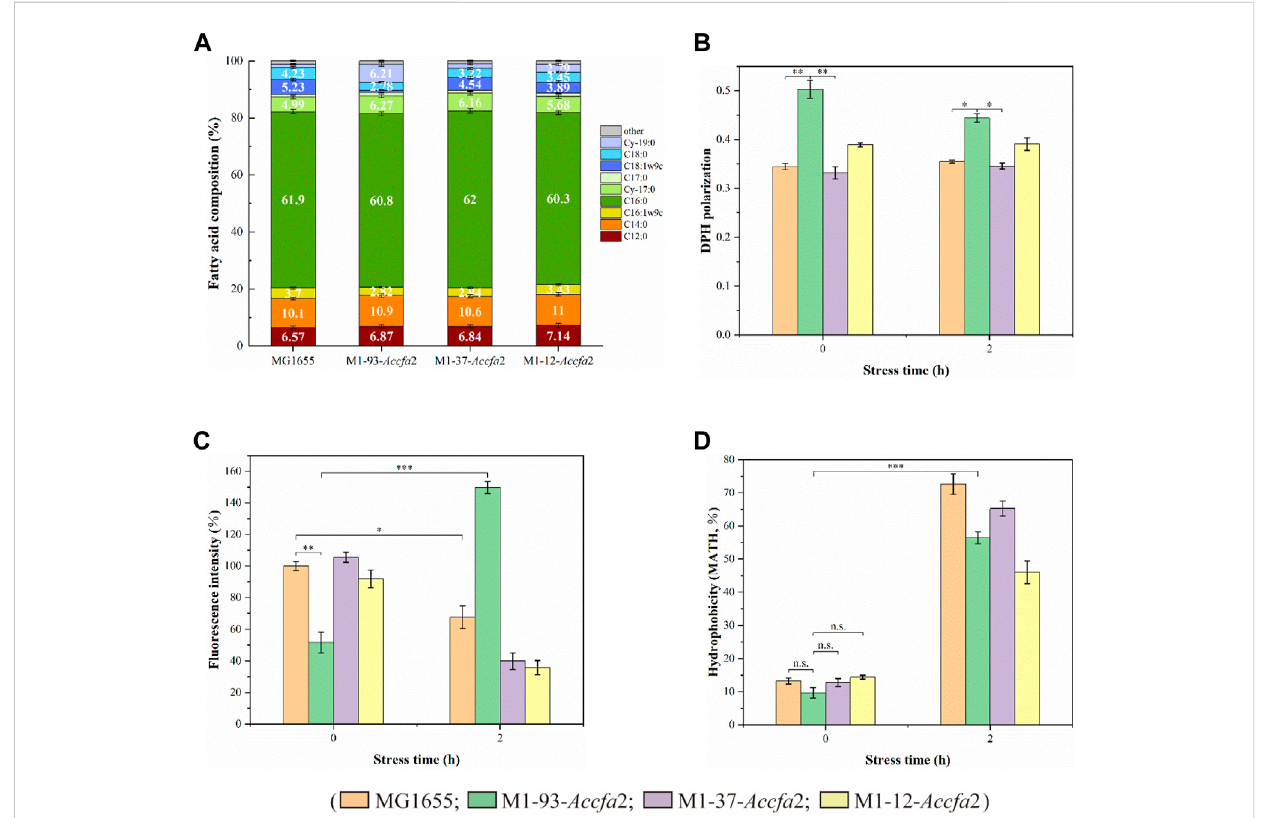
FIGURE 4 The heterologous expression of Accfa 2 altered themembraneproperties of E. coli . (A) The fatty acid pro fi les ofstrains MG1655, M1-93- Accfa 2, M1- 37- Accfa 2and M1-12- Accfa 2cultivated to theexponential phasein Eminimal medium. (B – D) The alterationsin cell membrane fl uidity, permeability and relativehydrophobicity ofcellsurfaceoftheabove fourstrains beforeand after exposure to acid stress, respectively. Theerror barsrepresented means± standard deviations